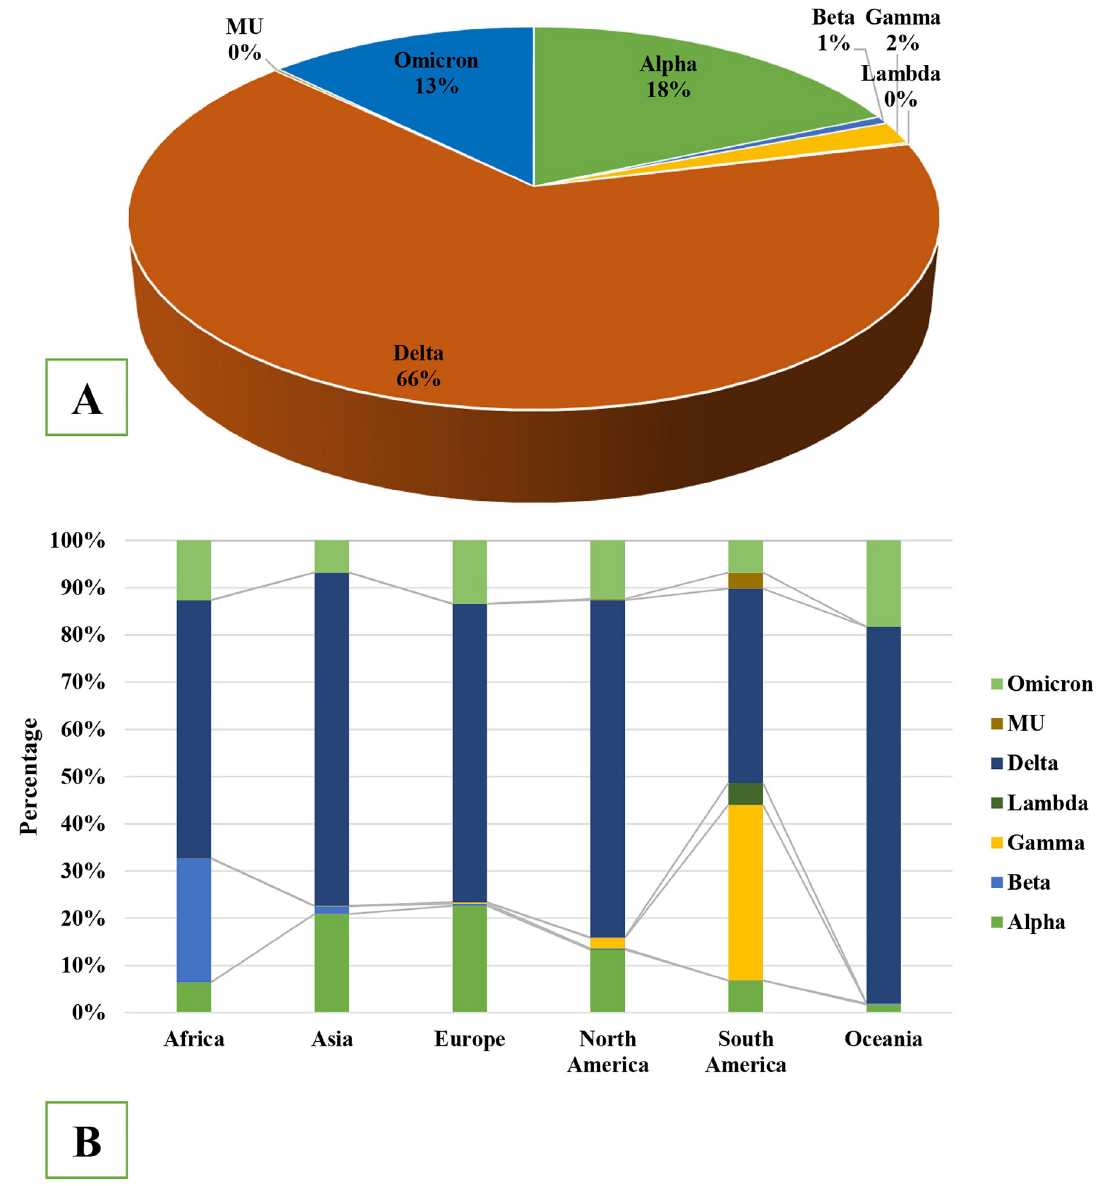
Fig 2. (A) Global frequency distribution of 7540558 whole genome of SARS-CoV-2 among variants of concerns identified during December, 2019 to January, 2022. (B) Percentage of variant of concerns of SARS-CoV-2 circulating throughout the six continents during the COVID-19